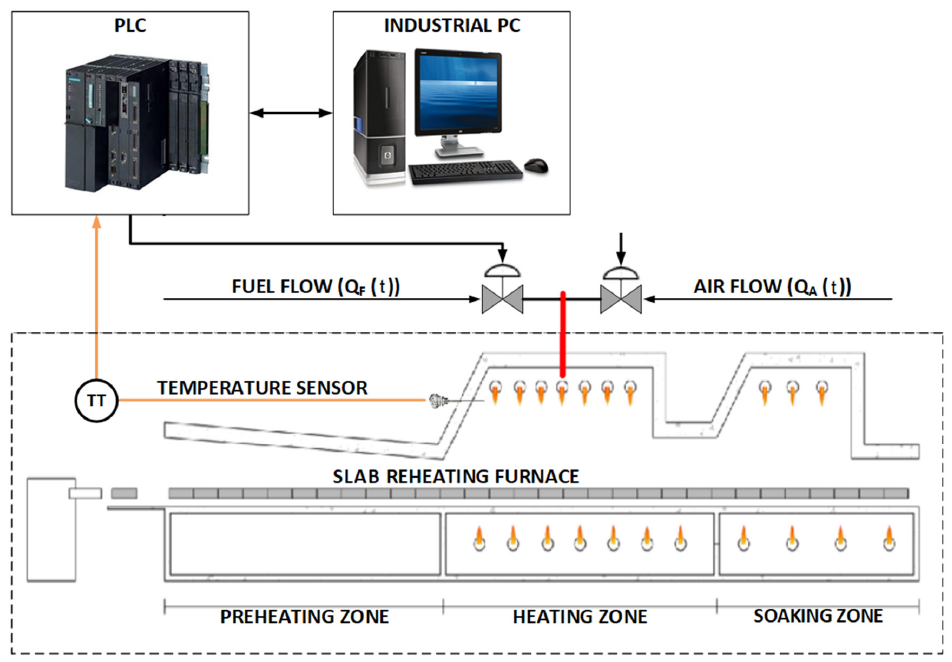
Figure 1. Diagram of the experimental arrangement for the collection of output/input data of the heating zone of the slab reheating furnace under study. PLC: Programmable Logic Controller, PC: Personal Computer.